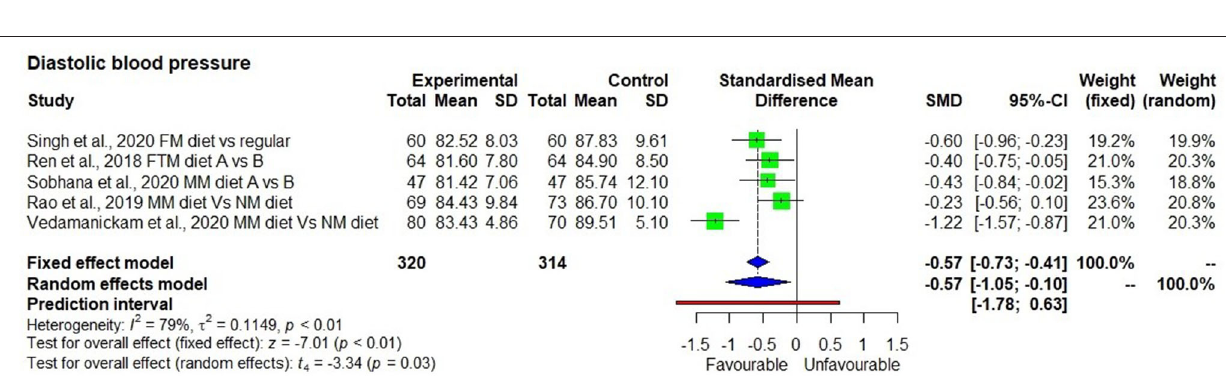
FIGURE 10 | Effect of consuming millets on diastolic blood pressure of the participants (pre- vs. post-treatment or intervention vs. control diet).